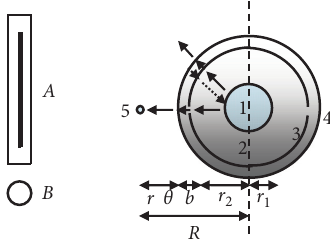
Figure 1: Schematic of the cutting seam cartridge blasting